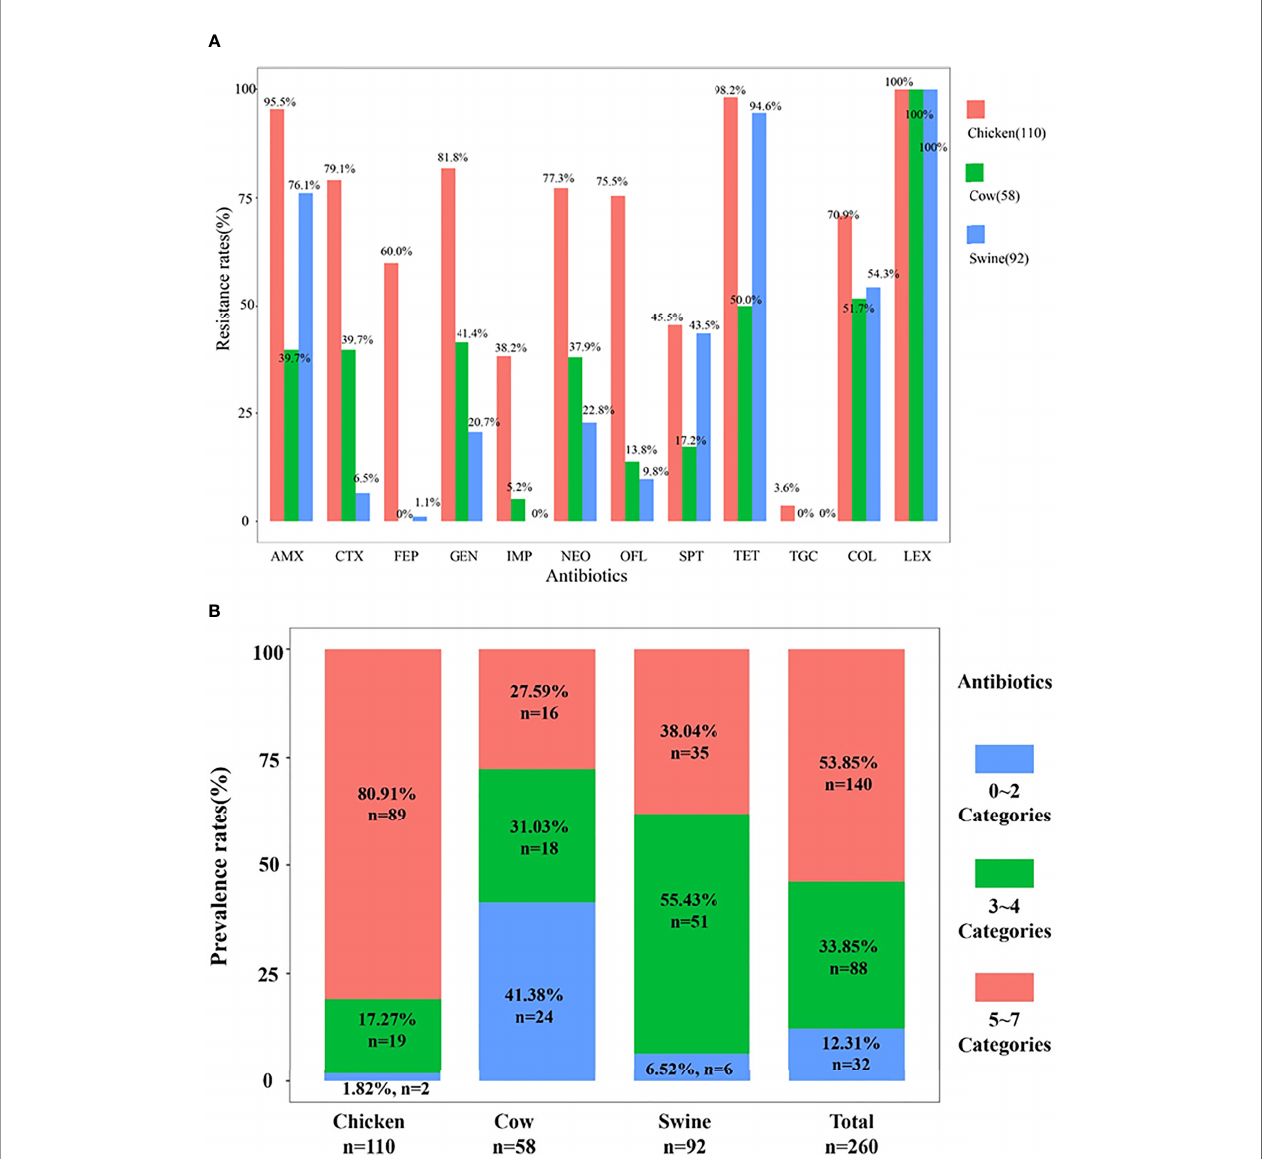
FIGURE 2 | The resistance rates and multidrug resistance rates. The resistance rates of 260 isolates are shown in (A) . The prevalence rates of multidrug resistance among 260 ESBL-EC are shown in (B)